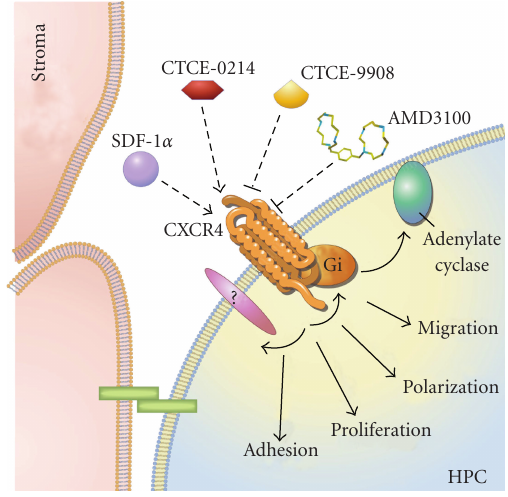
Figure 1: SDF-1 α /CXCR4 axis and interaction with small molecules. The chemokine stromal cell-derived factor-1 alpha (SDF-1 α or CXCL12) is secreted by stromal cells with various e ff ects on hematopoietic progenitor cells (HPCs). It binds to the CXCR4 receptor and this interaction can be influenced by the peptide ago- nist CTCE-0214 as well as by the peptide antagonists CTCE-9908 or the nonpeptide antagonist